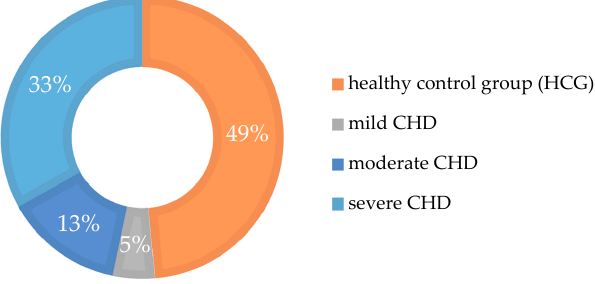
Figure 1. Incidence of congenital heart defects (CHD) and healthy children (HCG) in the current study. Categorization into three severities according to Warnes et al. [ 19 ] . Table 1. Distribution of high risk dmf-t values in the groups of CHD compared to HCG according to the criteria of the German association for youth dental care (DAJ) [26].